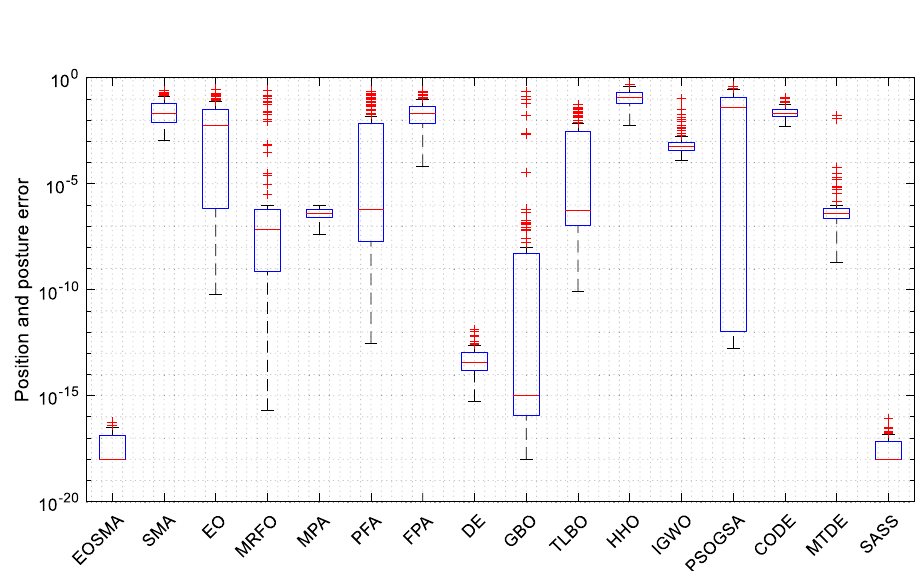
Figure 15. Box plot of optimization results of randomly generated pose